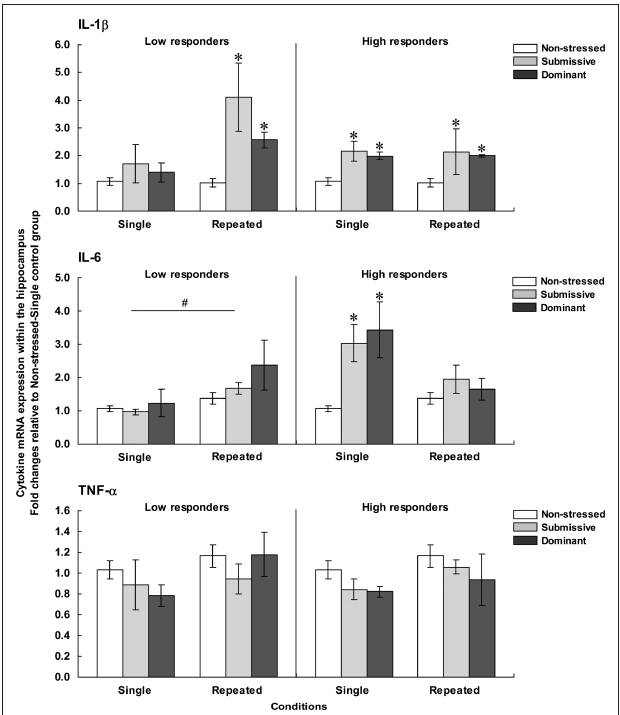
Figure 5 | Fold changes for mrNA expression of iL-1 β (top), iL-6 (middle), and TNF- a (bottom) within the hippocampus in non-stressed mice as well as in submissive and dominant mice engaged in single or repeated aggressive encounters. Fold changes were relative to the Non-stressed – Single control group. Data for low corticosterone responders are shown in the left panel, whereas data for high responders are depicted in the right panel. The N /group was the same as that described in Figure 1 . Data represents means ± SEM. * p < 0.05 relative to non-stressed mice. # p < 0.05 relative to the single